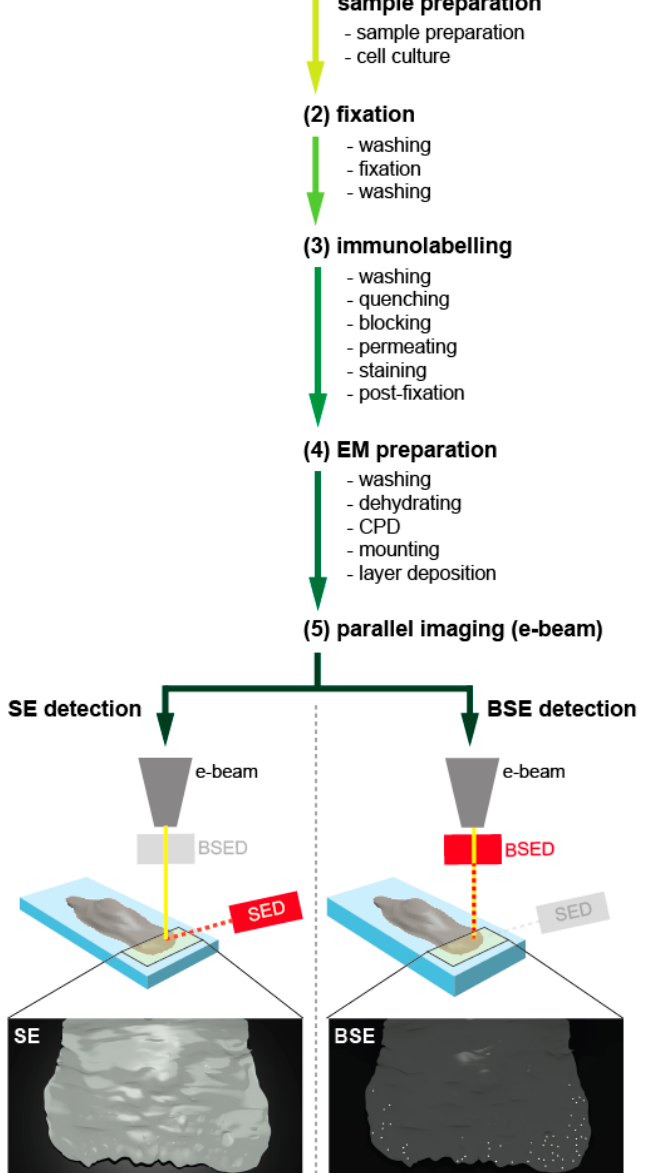
Figure 1. Overview of experimental design. The graphical summary depicts the five main components of the experimental setup. After holder and sample preparation ( 1 ), which is individually designed according to the requirements of the electron microscope, the biological sample has to be prepared. Pre-fixation ensures structure and protein stability ( 2 ), and the labelling procedure, which needs to be optimized with respect to the sample, the protein of interest, and the the protein localisation ( 3 ). Before the sample can be imaged, it has to be finalised for EM preparation respective antibody, endures the protein localisation ( 3 ). Before the sample can be imaged, it has to ( 4 ). Finally, the probe can be imaged on the same microscope, simultaneously collecting the secondary be finalised for EM preparation ( 4 ). Finally, the probe can be imaged on the same microscope, electrons (SE, left ) for ultrastructural information and the back-scattered electrons (BSE, right ) for the simultaneously collecting the secondary electrons (SE, left ) for ultrastructural information and the visualisation and localisation of the gold-conjugated antibodies ( 5 back-scattered electrons (BSE, right ) for the visualisation and localisation of the gold-conjugated antibodies ( 5 ).